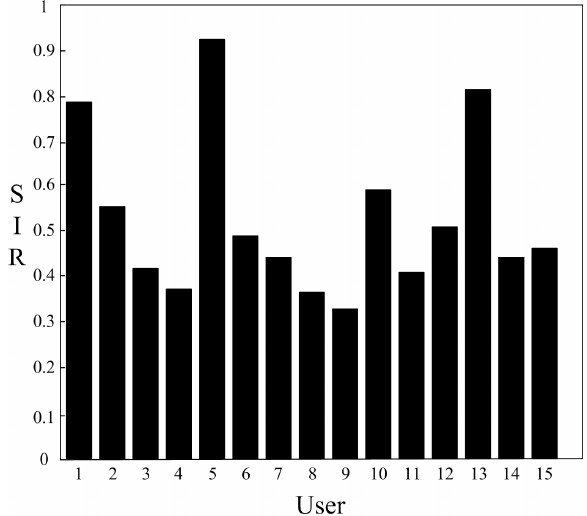
Figure 5. The initial transmission efficiency of the 15 CR users.